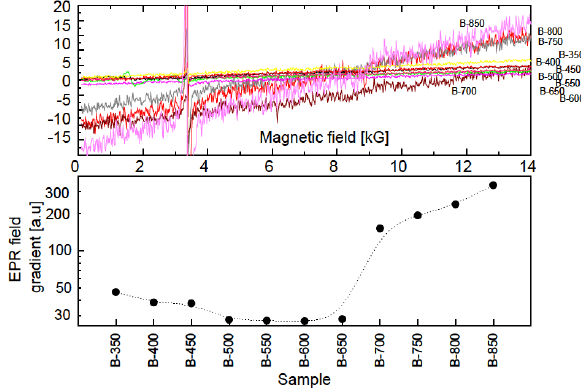
Figure 6: (Top panel) The EPR spectra at RT of all investigated sam- ples registered in the whole applied magnetic field range; (bottom panel) EPR magnetic field gradient of the VB component in all stud- ied